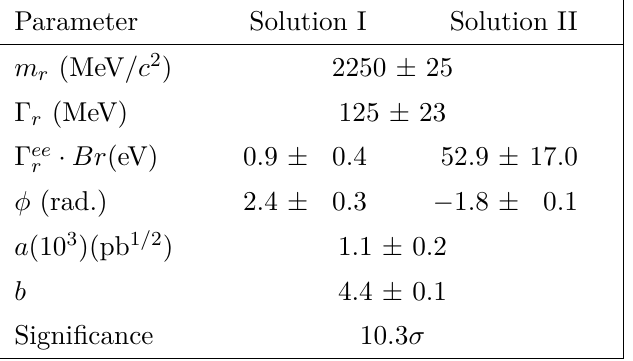
Table 7 . Resonance parameters obtained in the fit to the e + e − → ωπ + π − cross section. The uncertainties are statistical